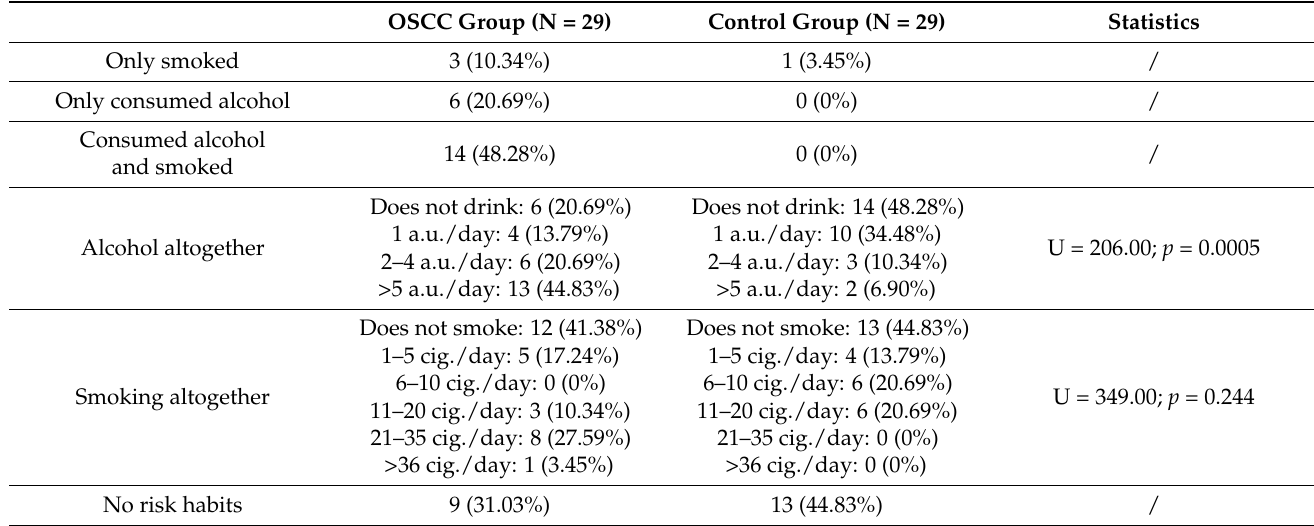
Table 1. Oral squamous cell carcinoma (OSCC) group and control group risk habits.